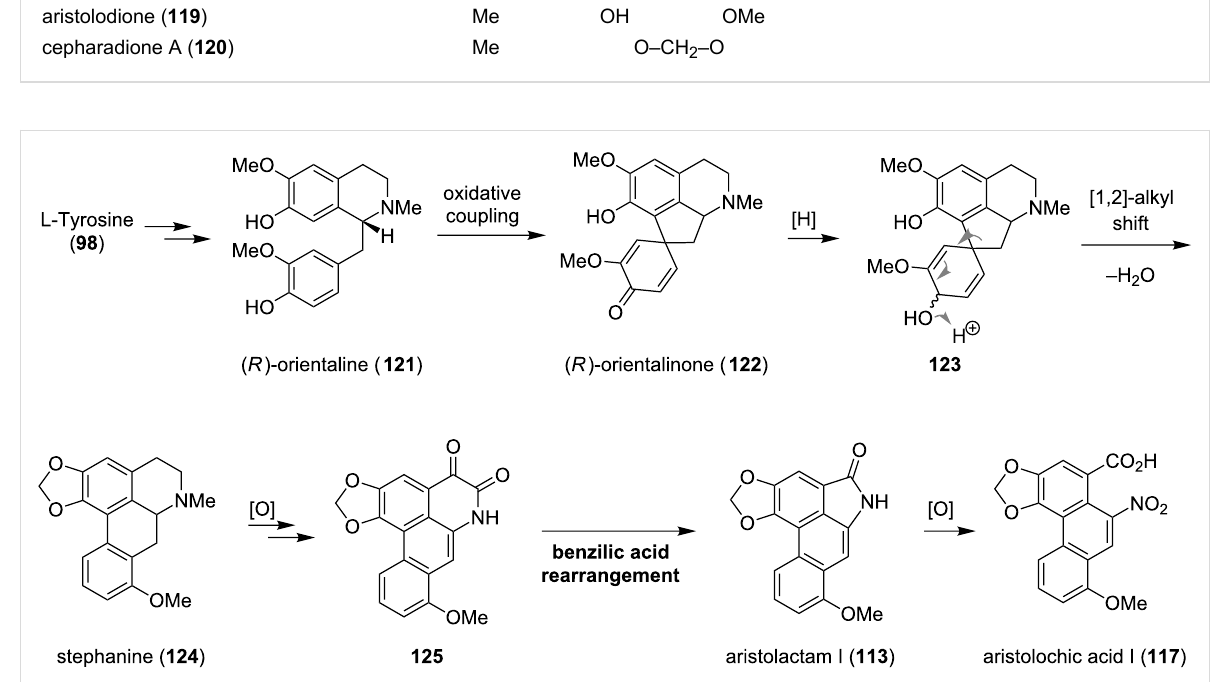
Scheme 14: Proposed biosynthesis of 113 , 117 and 125 .